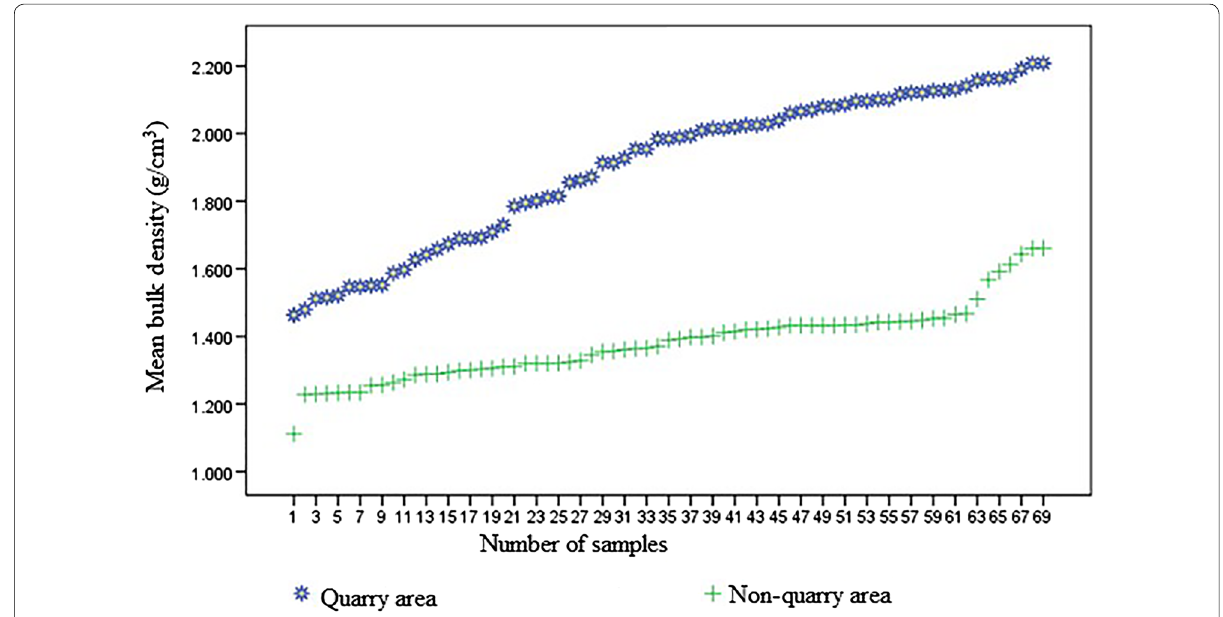
Fig. 3 Soil bulk density of quarry and non-quarry areas